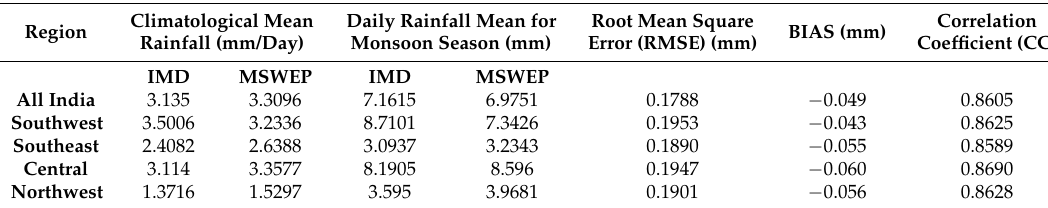
Table 3. Statistics of daily rainfall over 1979–2013.